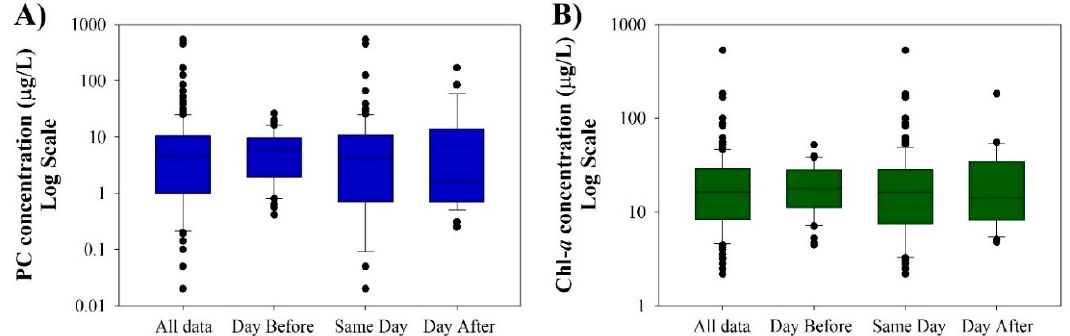
Figure 6. Boxplots for PC and chl- a concentration for each dataset ( A ) For PC concentration; ( B ) For chl- a concentration.